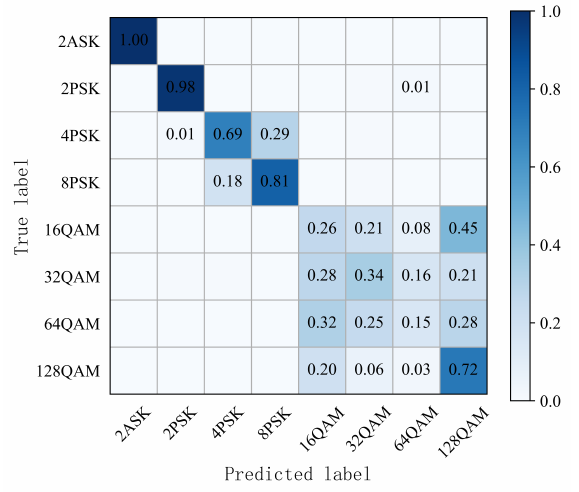
Figure 10. Confusion matrix for different modulated signals at a frequency offset of 50 kHz when the SNR is − 10